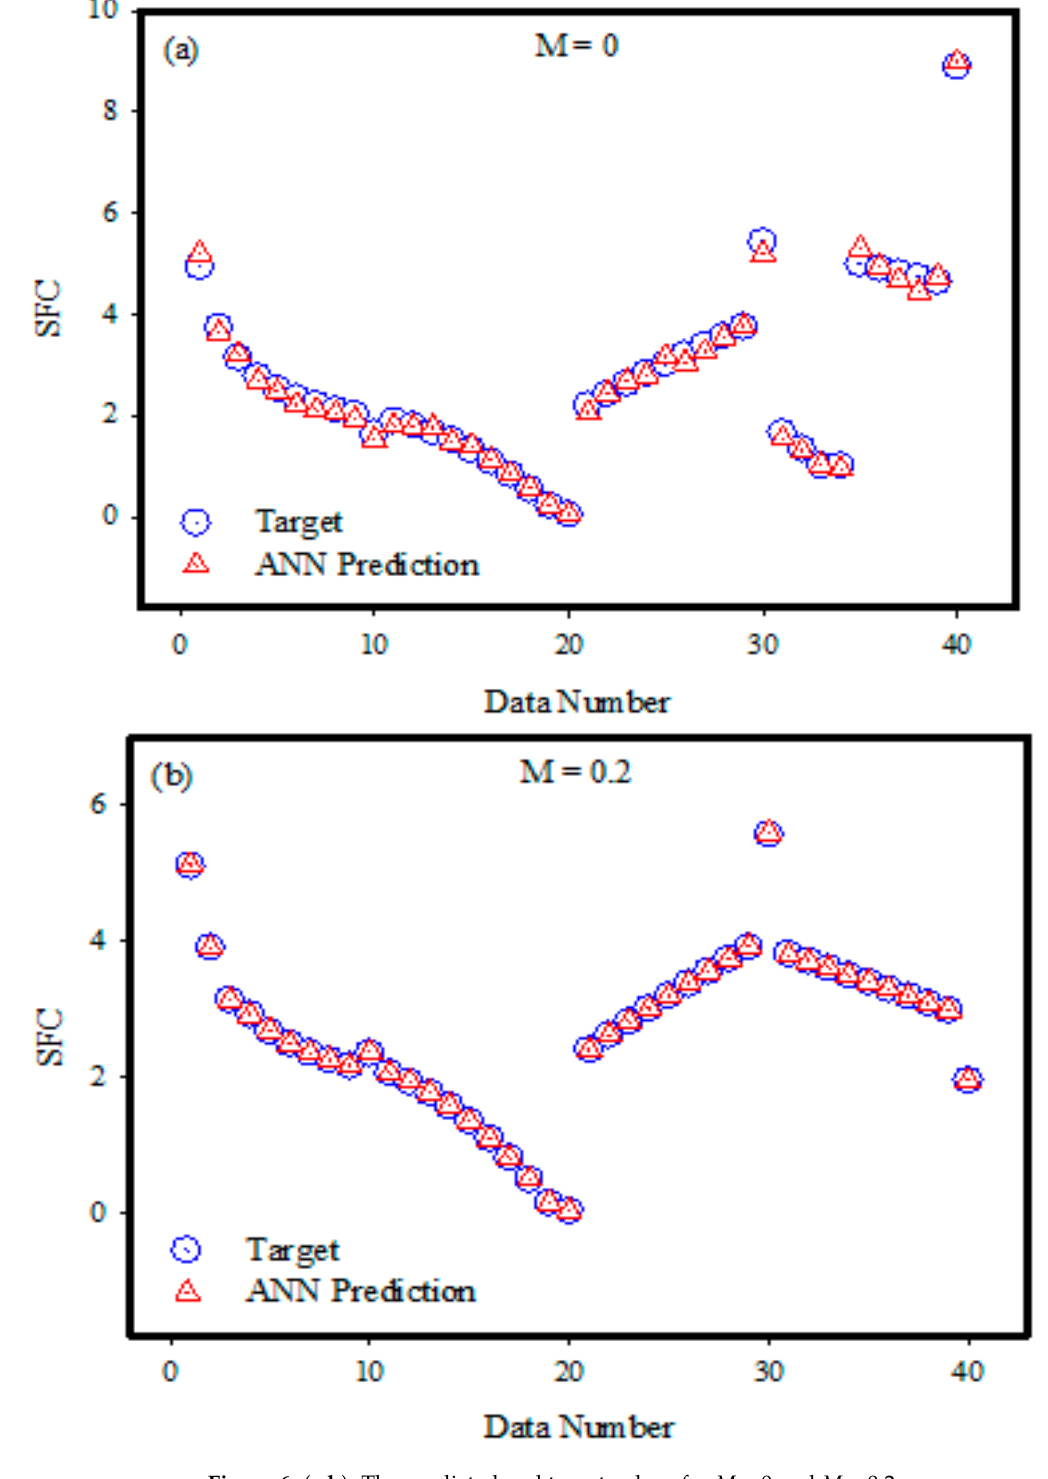
Figure 6. ( a , b ). The predicted and target values for M = 0 and M = 0.2. When the outcomes for each data point are analyzed, the graphs clearly show that the ANN model results are in very good agreement with the goal values. This excellent